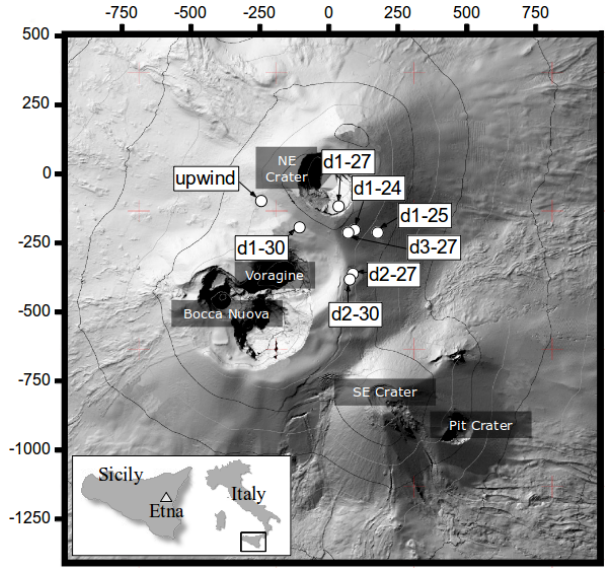
Figure 1. Map of the sampling sites and summit craters. Terrain from Neri et al. (2009). Coordinates are metres displacement from the NE